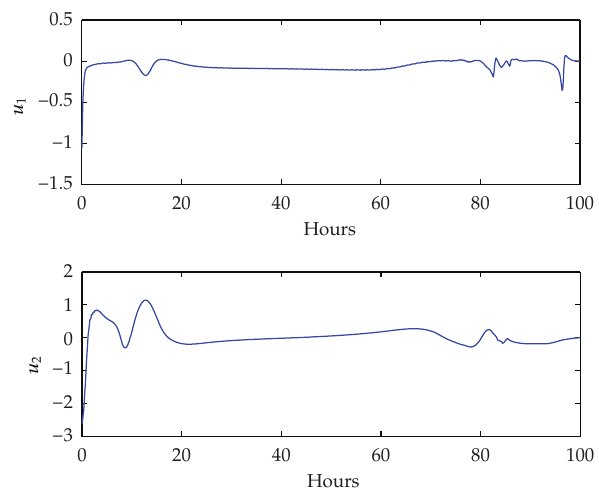
Figure 7: The optimal control graph for the two controls, namely, immune boosting and pathogen sup- pressing